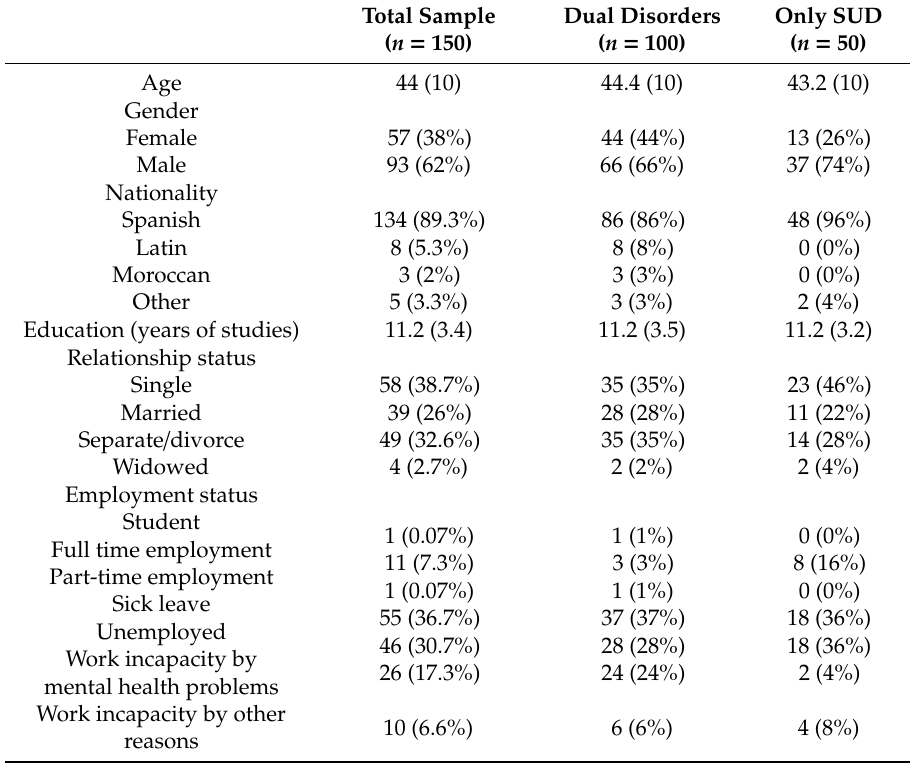
Table 1. Sociodemographic characteristics of the sample. Data are presented as mean (SD) or number